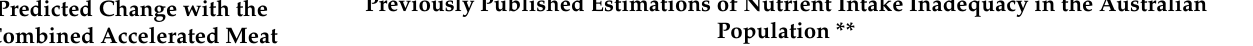
Table 4. Combined Accelerated Meat and Milk Scenario results for various population groups in relation to levels of nutrient intake inadequacy reported in the 2011–12 Australian National Nutrition and Physical Activity